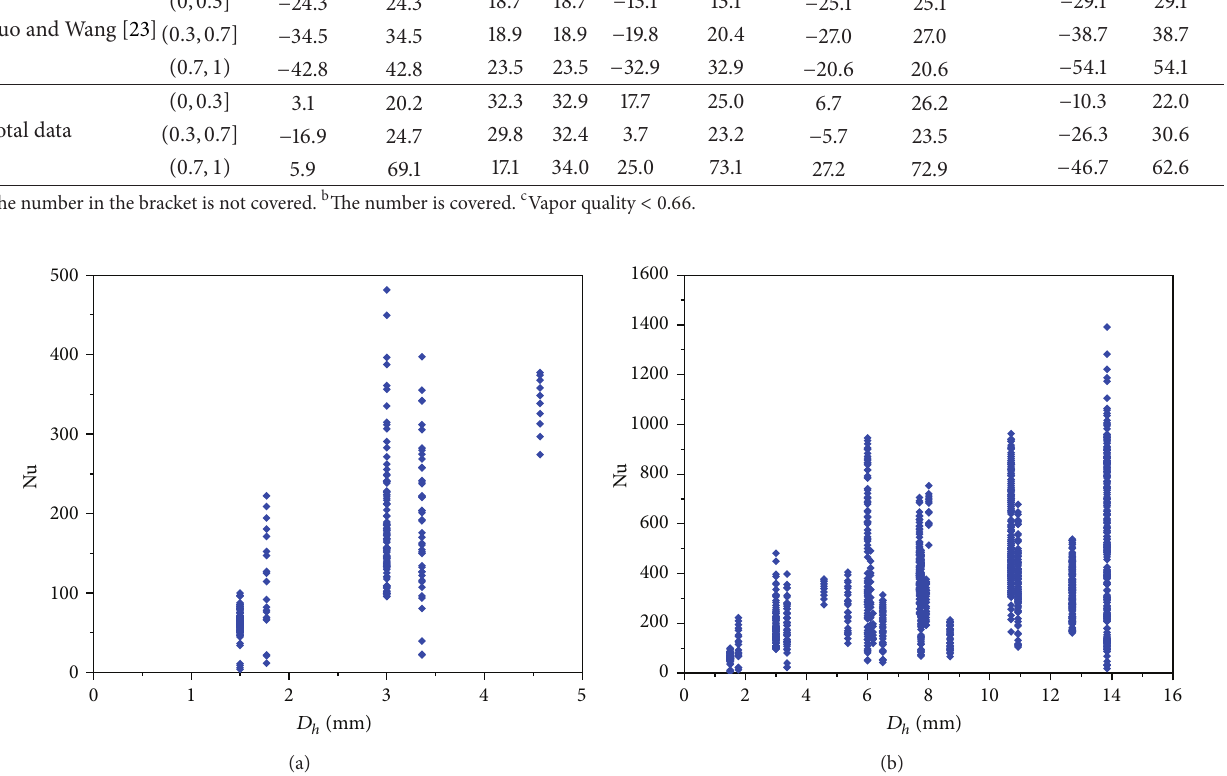
Figure 4: Statistics of the database with 𝐷 ℎ and Nu as variables.